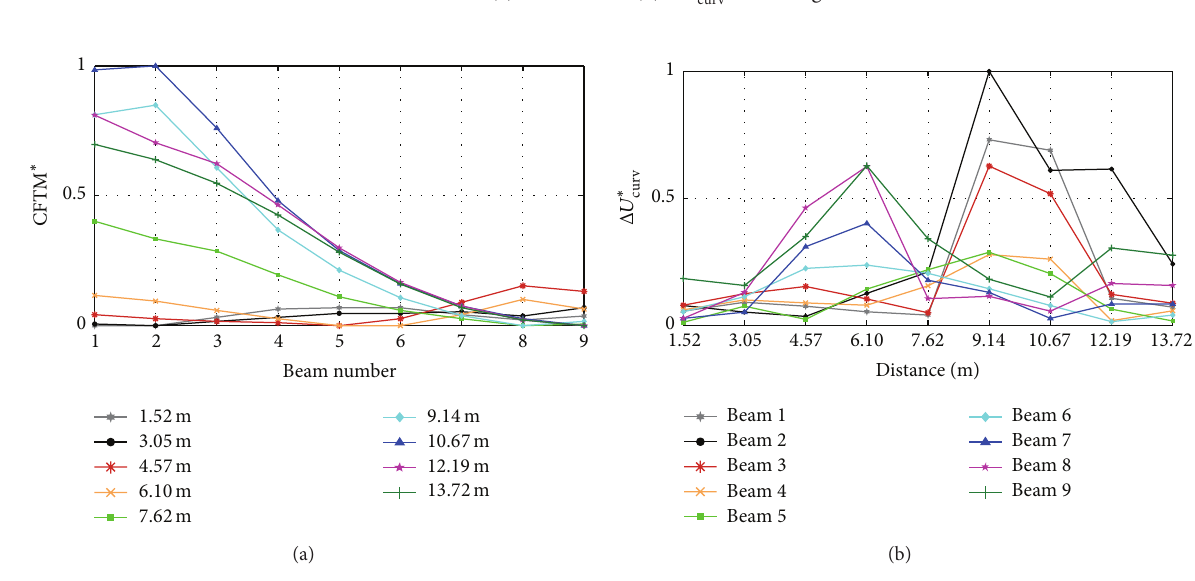
for damage case 4. curv